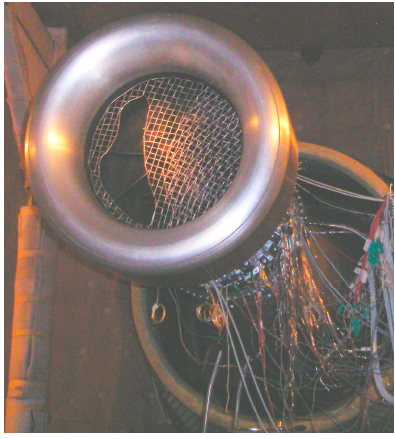
Figure 16. Fan inlet duct with the flow distortion simulator.